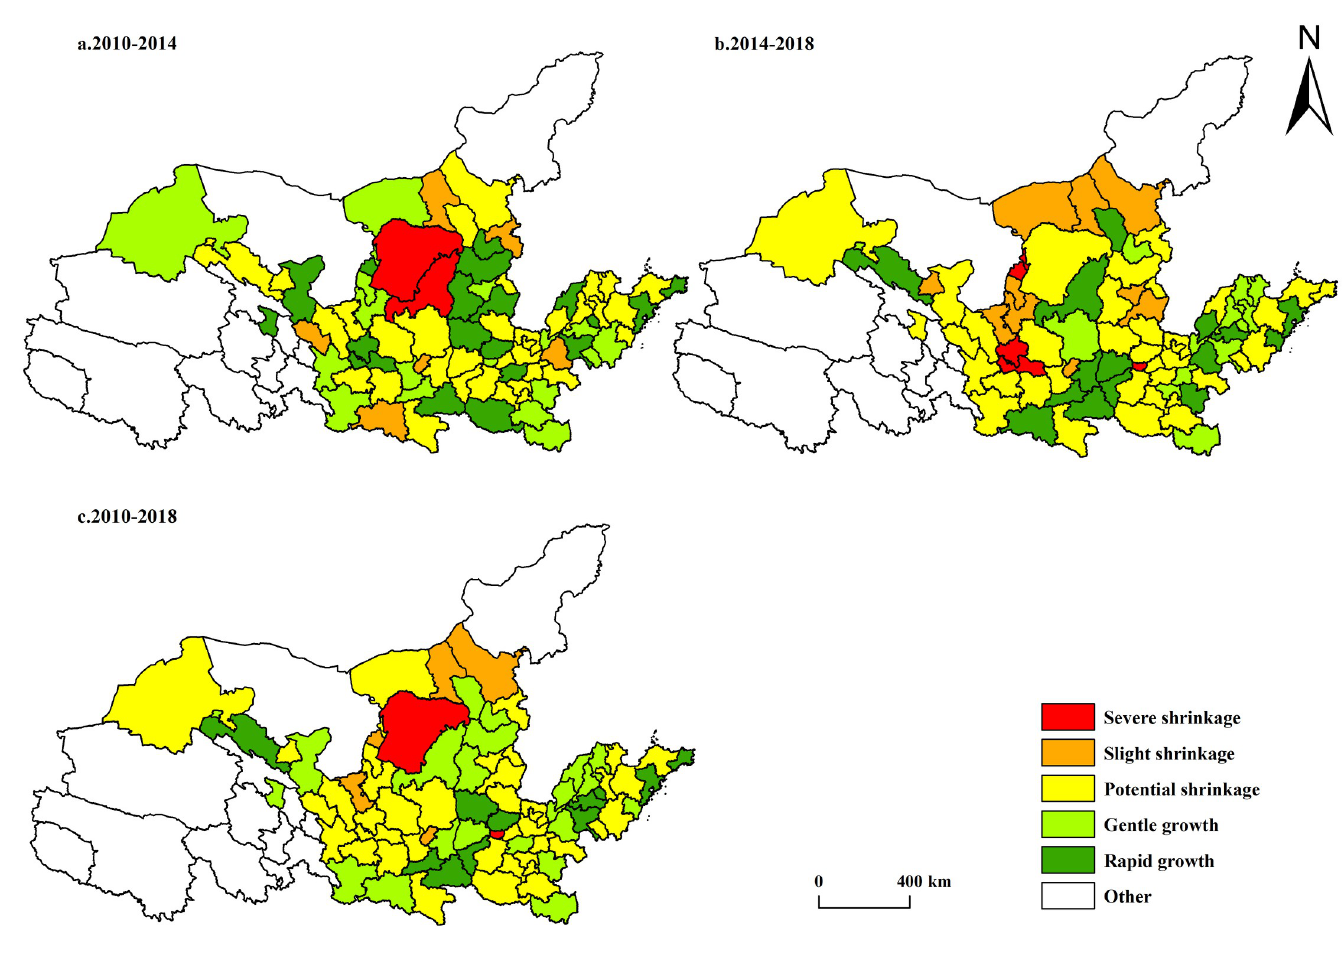
Fig 2. Spatiotemporal differentiation of population-shrinking cities in the Yellow River Basin. The basic map came from a public map from the standard map service website of the Ministry of Natural Resources of China. The drawing approval number is GS (2016)1593.